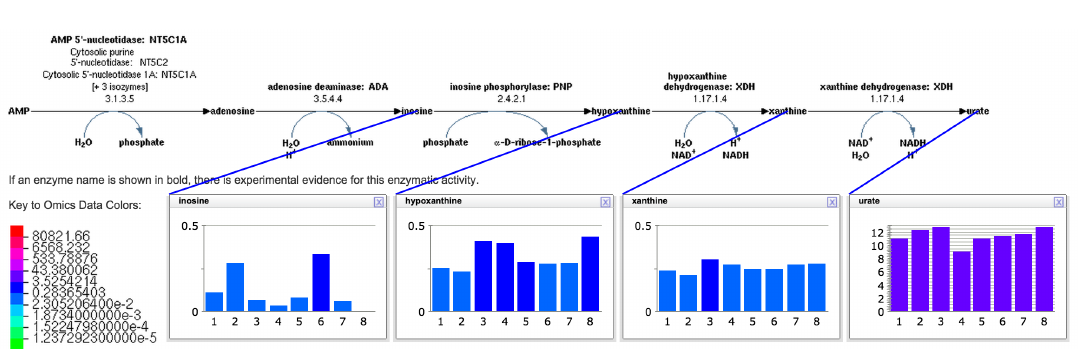
Figure 4. HumanCyc adenosine nucleotide degradation pathway (SALVADEHYPOX-PWY) overlayed with metabolomics data. The data for each metabolite are shown in a separate “omics pop-up” window with eight time points provided for each metabolite. Data were derived from metabolomics data of Chen et al. acquired during the second infection period (diabetic onset and respiratory syncytial virus infection). Data shown represent the daily mean of negative-mode LC-MS peak intensities computed from observed compound peaks in three technical replicates and scaled by a factor of